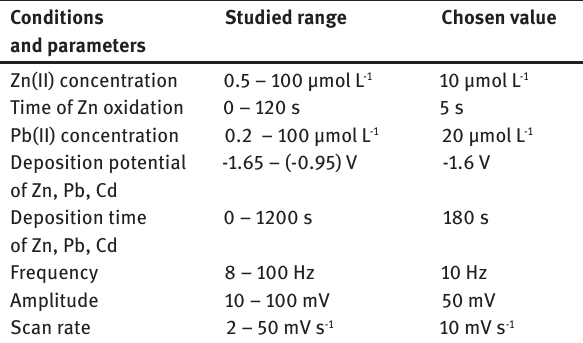
Table 1: Optimized voltammetric conditions and parameters for Cd(II) determination at the lead film screen-printed carbon electrode prepared with the use of a zinc mediator. Conditions